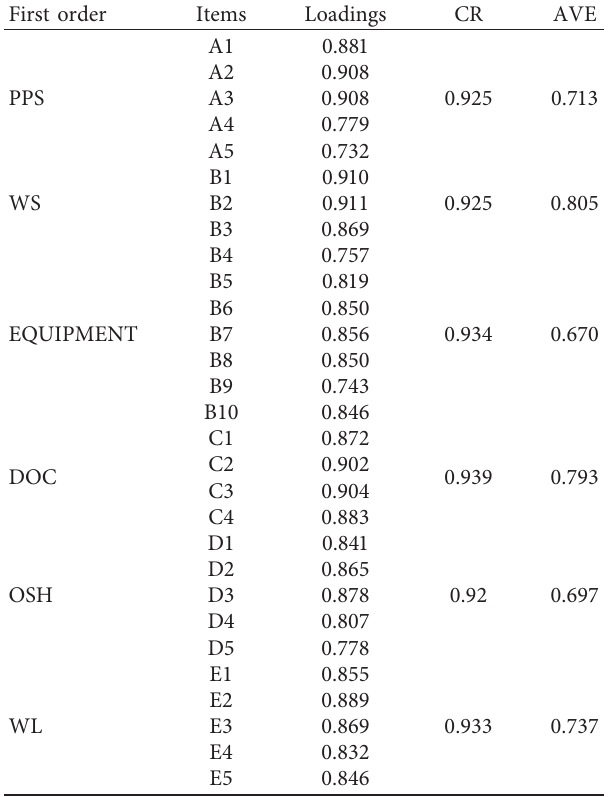
Table 3: Measurement model for reflective